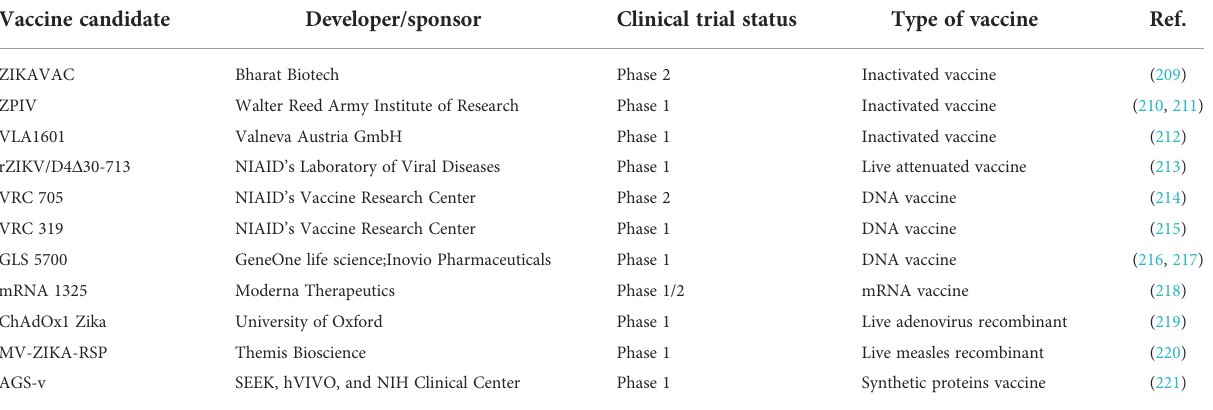
TABLE 1 A summary of the ZIKV vaccine candidates under different phases of human clinical trials. Vaccine